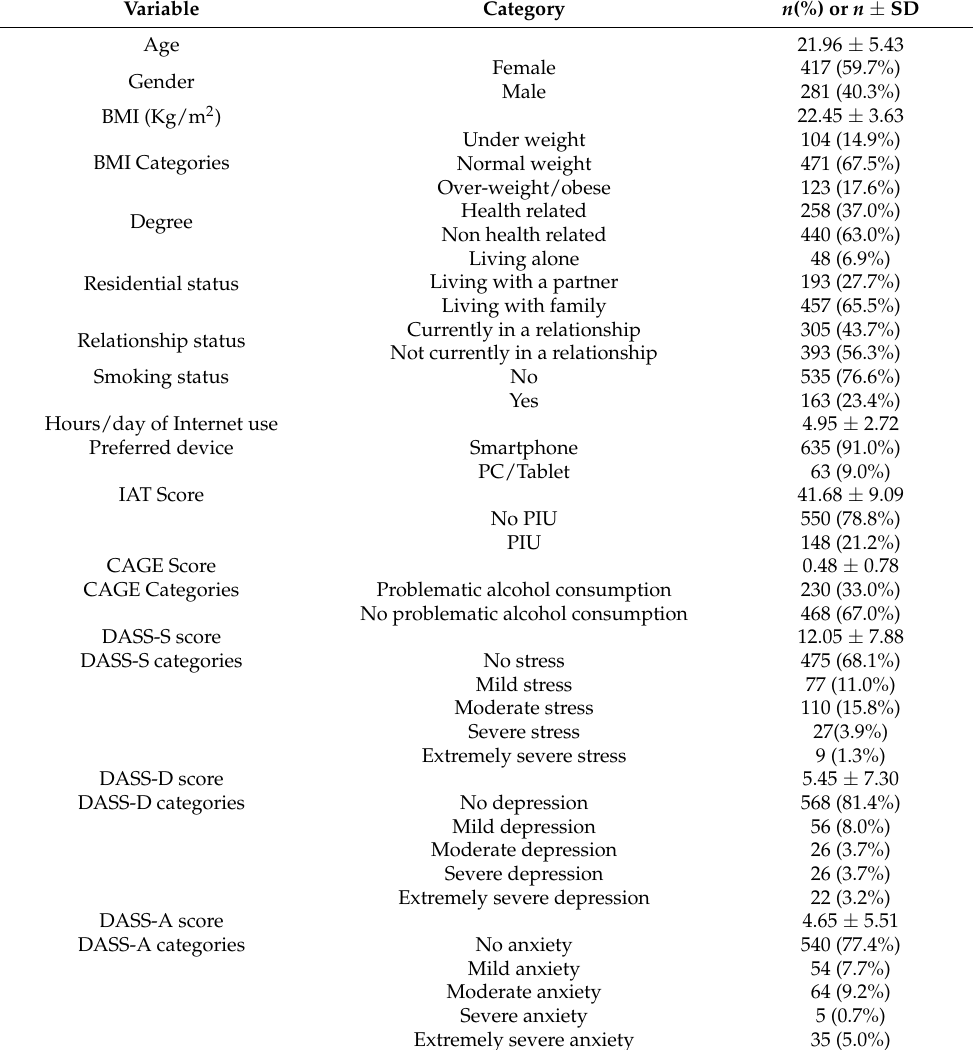
Table 1. Participant characteristics ( n = 698), number, % or mean ±